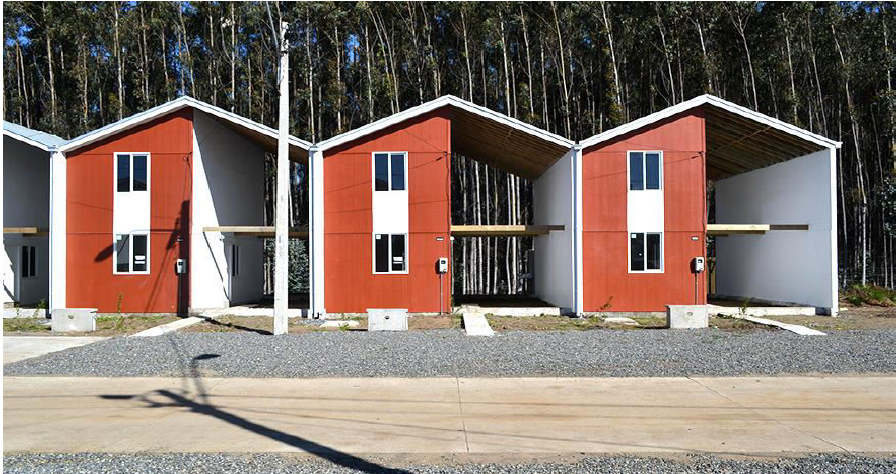
Figure 5: Elemental's Villa Verde project, Chile, with additional infrastructure over the incomplete half of the house. Archdaily,